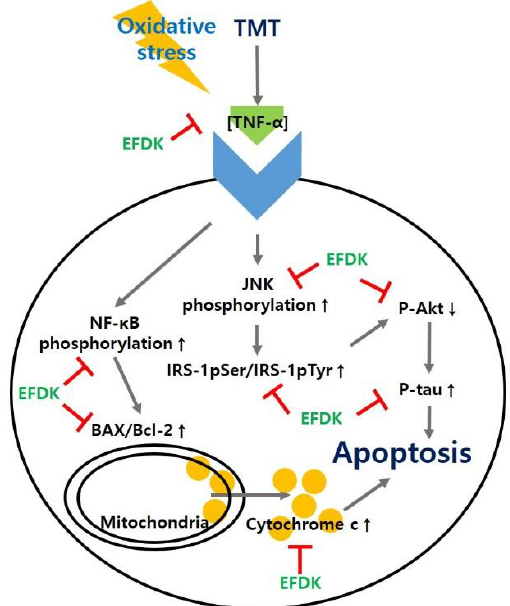
Figure 11. A schematic illustration shows the ameliorating effect of ethyl acetate fraction from persimmon (EFDK) in TMT-induced behavioral and memory dysfunction in ICR mice via regulation of the JNK/Akt signaling and apoptotic pathways.